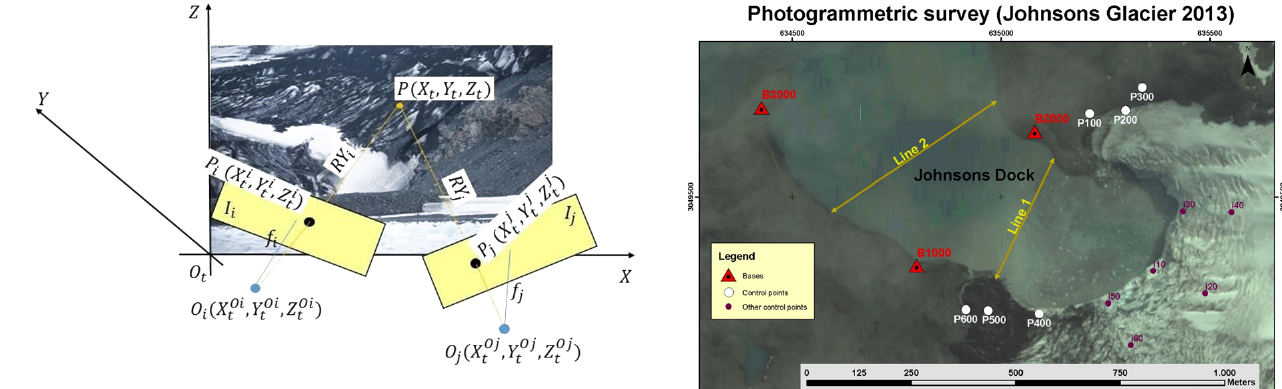
Figure 2. Photogrammetric restitution. By applying spatial similar- ity transformations (Kraus, 2007), one can calculate the unknown coordinates ( X t ,Y t ,Z t ) of a point P from its coordinates P i and P j on flat photographs taken from two different points of view O i and O j (locations of each camera) with known coordinates.